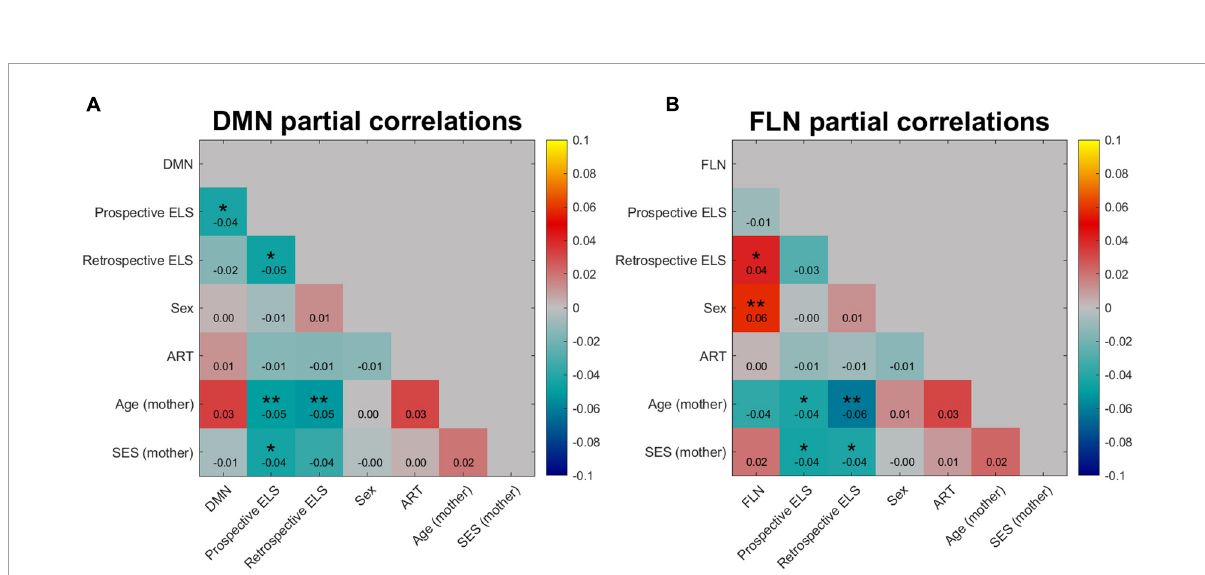
FIGURE4 Partial correlation of DMN (A) and FLN (B) network profile dissimilarities with dissimilarity matrices of prospective and retrospective ELS, with participant sex, assisted reproduction treatment (ART) history, mother’s age, and mother’s socio-economic status (SES) partialled out. Colors indicate the strength and direction of correlation between the dissimilarity matrices of variables, where blue represents negative correlations and red and yellow represent positive correlations. * p < 0.05, ** p <